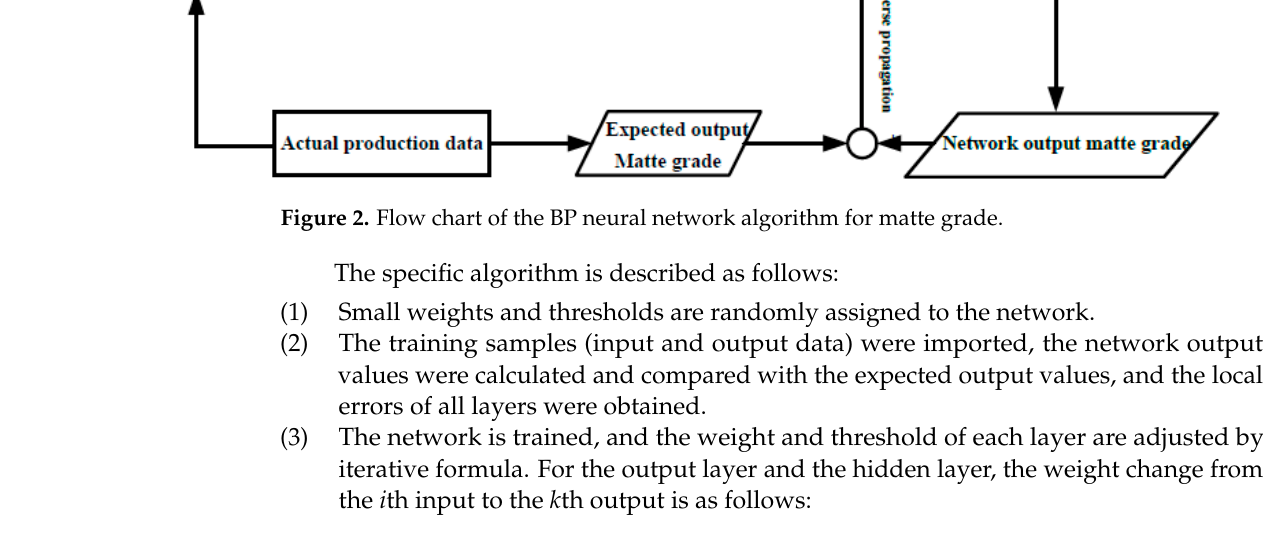
Figure 2. Flow chart of the BP neural network algorithm for ma tt e grade. The speci fi c algorithm is described as follows: (1) Small weights and thresholds are randomly assigned to the network.